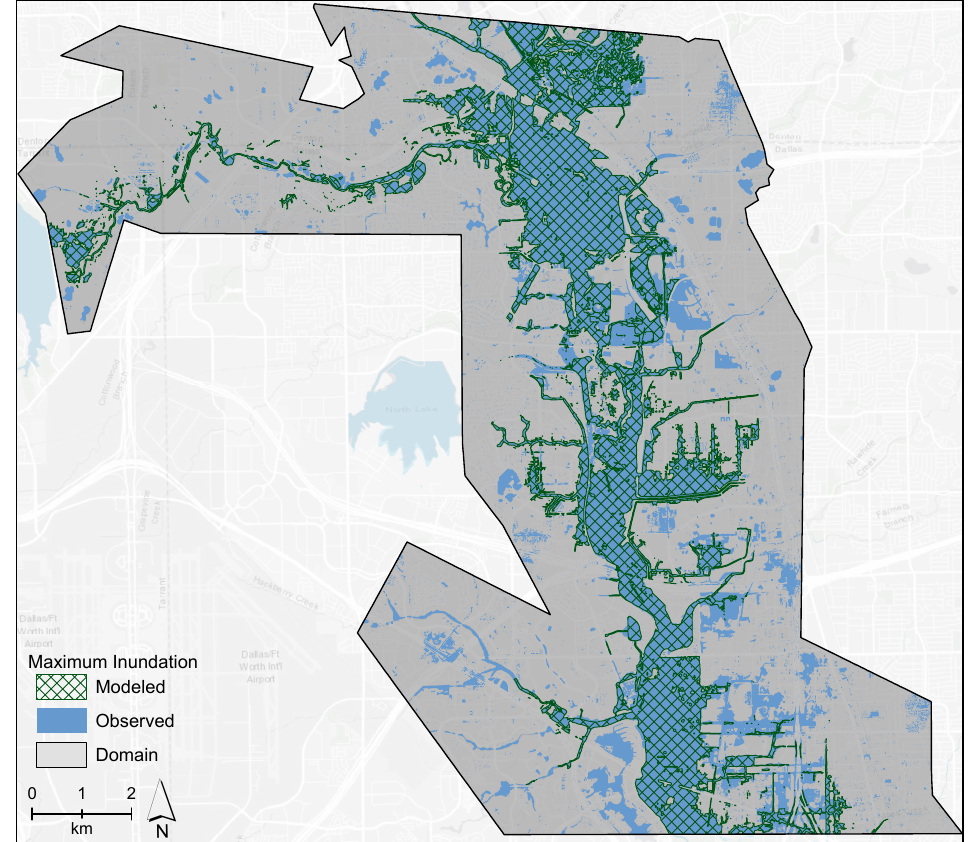
Figure 5. Water surfaces for each day are aggregated together to represent the maximum flood extent possible for the entire event. Inundation of the MOP is shown in light blue and the simulated HEC-RAS model output is overlaid in hashed